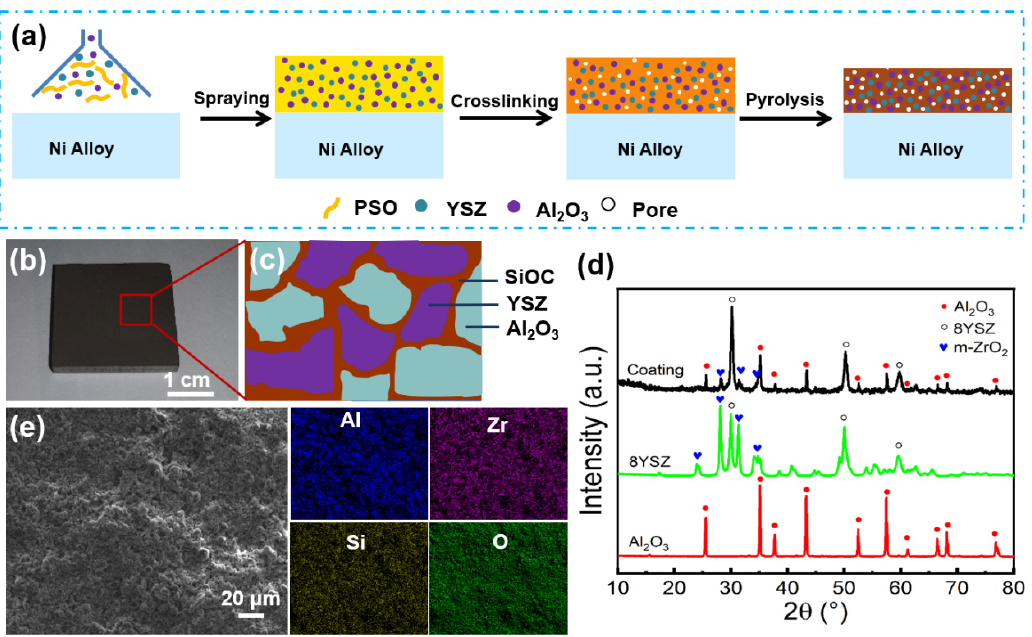
Figure 1. ( a ) Schematic illustration of preparation process of the SiOC/Al 2 O 3 /YSZ coatings, ( b ) pho- tograph, ( c ) simulation of phase structure, ( d ) XRD patterns, ( e ) SEM image and elemental mappings of the SiOC/Al 2 O 3 /YSZ coating: blue for Al, purple for Zr, yellow for Si, and green for O. The XRD pattern of the SiOC/Al 2 O 3 /YSZ coating shows strong characteristic peaks of the Al 2 O 3 crystalline phase (JCPDS no.9-0036, 2 θ = 35.2 ◦ , 43.4 ◦ , 57.5 ◦ and 68.2 ◦ ) and 8YSZ crystalline phase ((Zr 0.94 Y 0.06 )O 1.88 , JCPDS no.89-9068, 2 θ = 30.2 ◦ , 50.2 ◦ , 50.6 ◦ ,